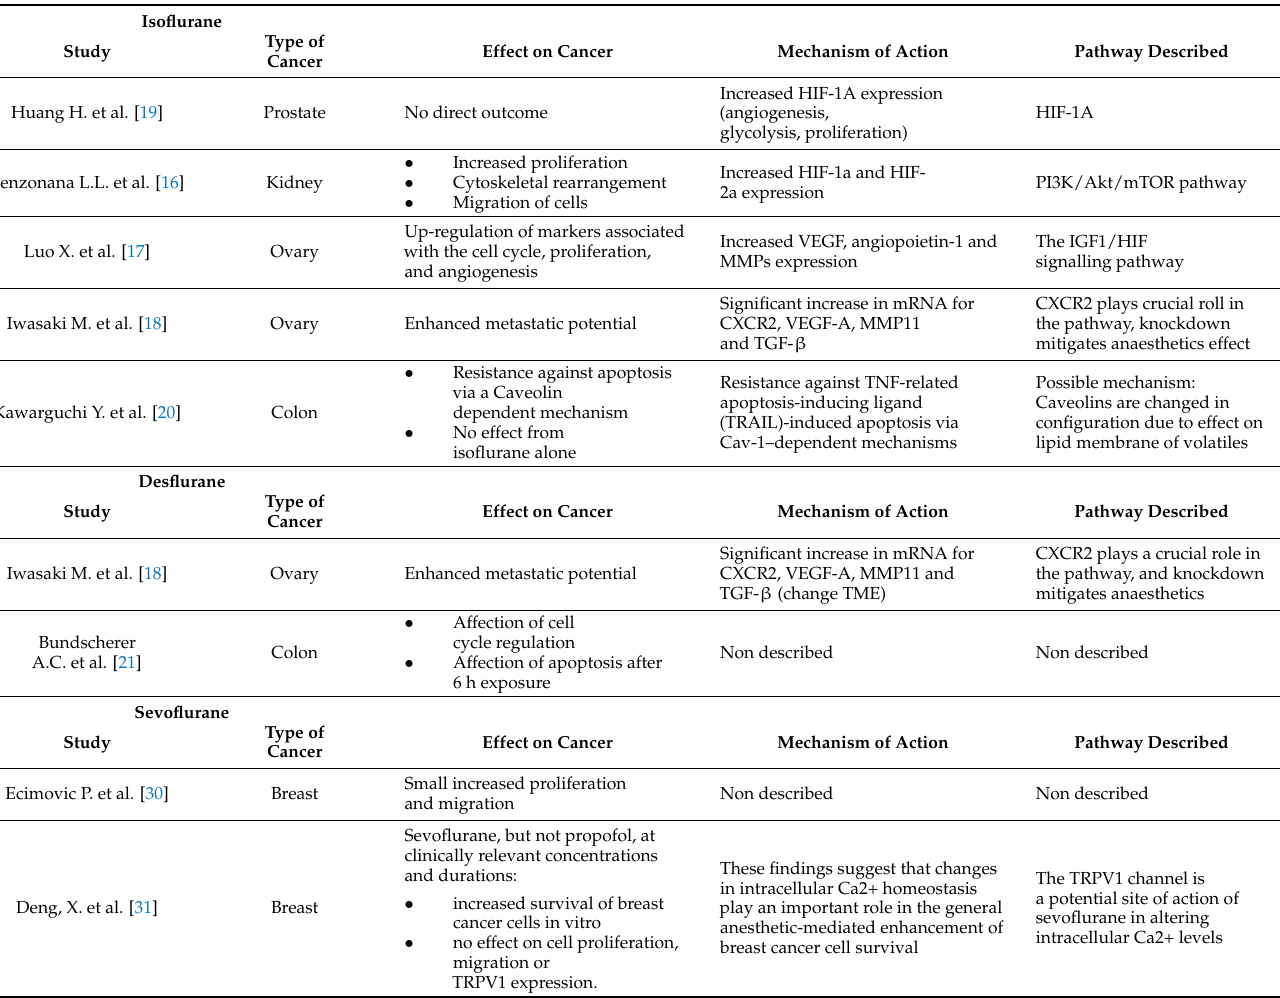
Table 2. Studies describing the direct effects of isoflurane, desflurane and sevoflurane on cancer cells, the associated mechanisms of action, and their respective pathways 1